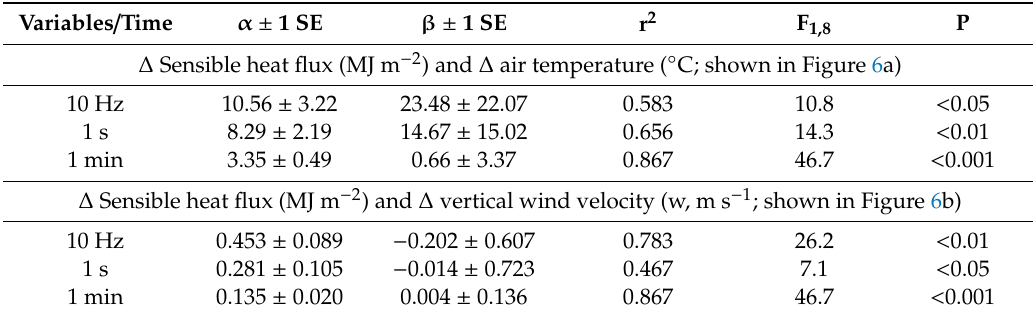
Figure 6. Relationships between maximum ∆ sensible heat flux and maximum ( a ) ∆ air temperature and ( b ) ∆ vertical wind velocity measured at 10 Hz and integrated to 1 s and 1 min intervals. Sensible heat flux was calculated at 10 min intervals. Statistics are shown in Table 6. Table 7. Linear models of maximum ∆ sensible heat fluxes calculated over 10 min intervals and maximum ∆ air temperature or maximum ∆ vertical wind velocities measured at 10 Hz and integrated to 1 s and 1 min values during the eight prescribed fires. Data were fit to the equation y = α × (variable) + β .